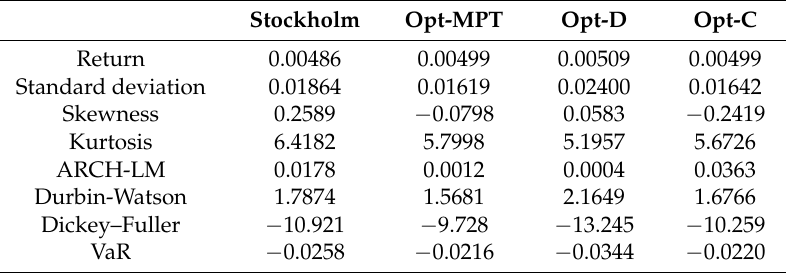
Table 10. The evaluation of the